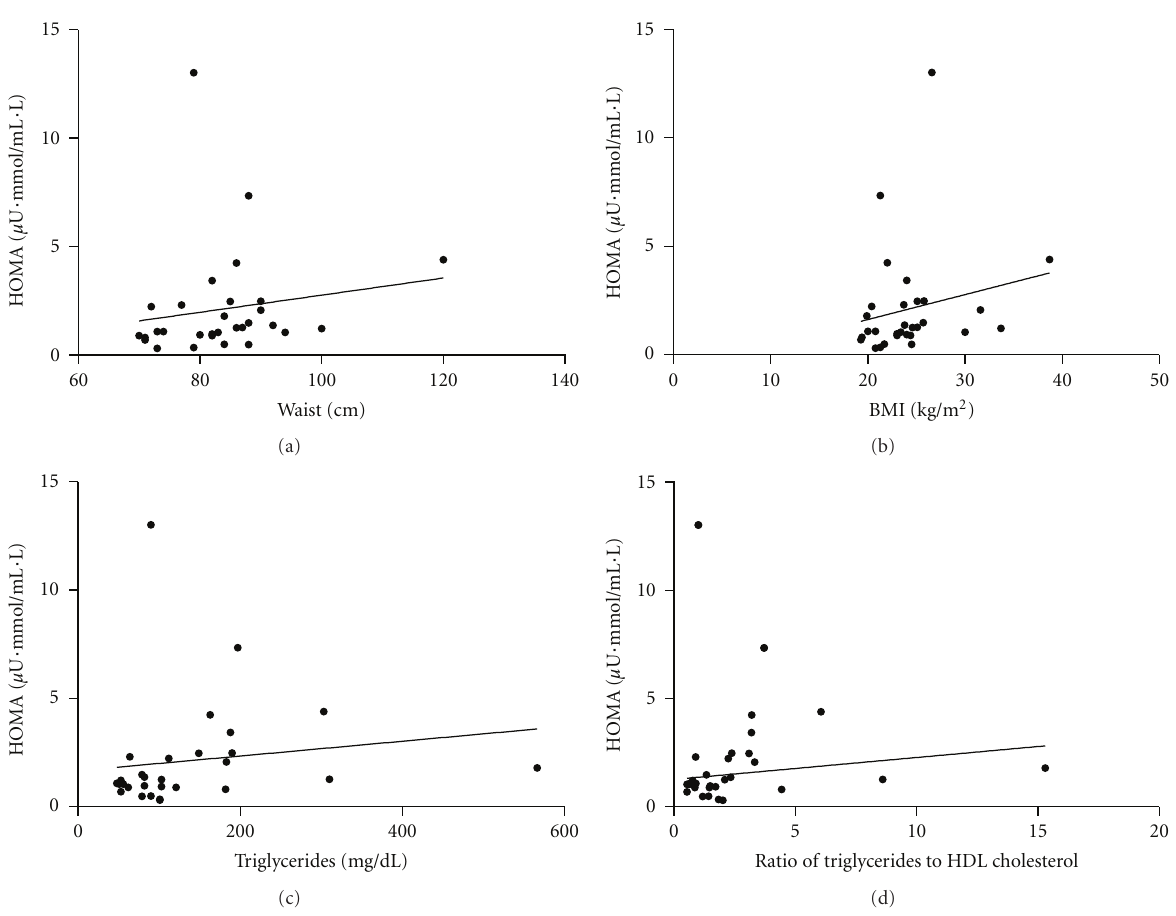
Figure 2: Relationship between HOMA index and waist (a), BMI (b), TG (c), and ratio of TG to HDL cholesterol (d) in patients with nondiabetic RA. In nondiabetic RA patients, HOMA index was significantly correlated with (a) waist ( r = 0 . 381, P = 0 . 038), (b) BMI ( r = 0 . 374, P = 0 . 042), (c) TG ( r = 0 . 444, P = 0 . 014), and (d) ratio of TG to HDL cholesterol ( r = 0 . 423, P = 0 .